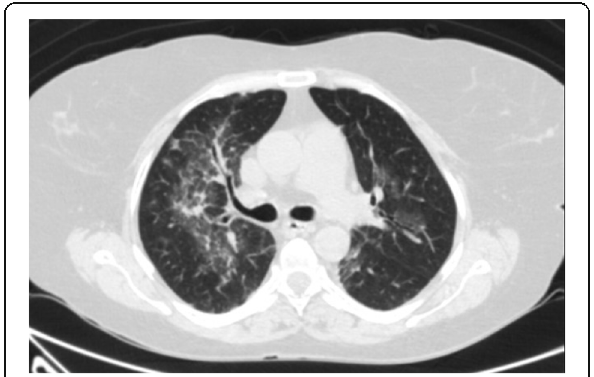
Fig. 13 Pneumonia due to P jiroveci infection: thin section CT shows parahilar GGO with reticulation (crazy-paving